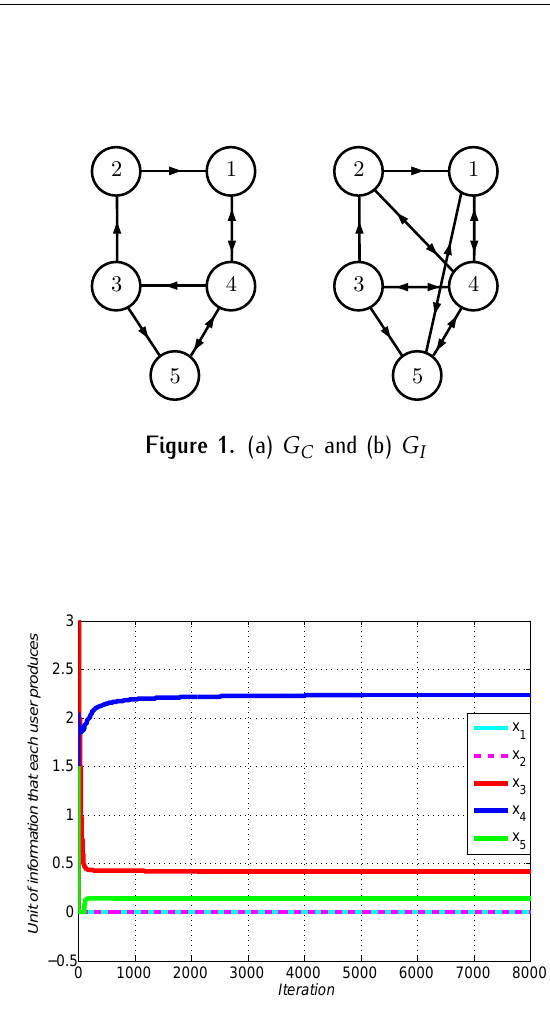
Figure 2. Convergence to a NE for the unit of information that each user produces over G C